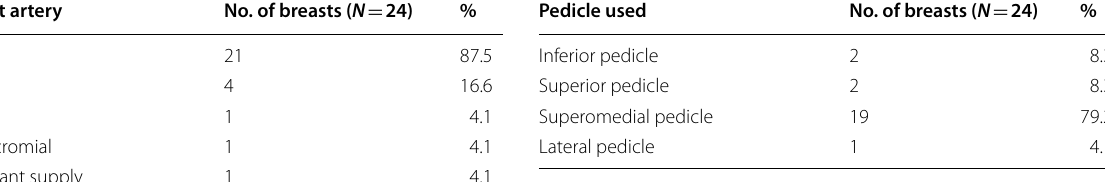
Table 3 Summary of pedicle used based on CTA findings Pedicle